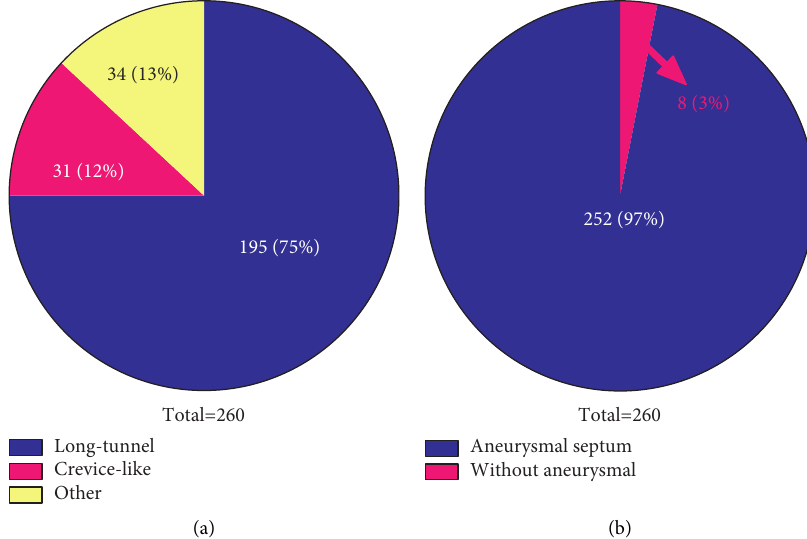
Figure 3: Anatomical classification based on transesophageal echocardiography. (a) Blue represents long-tunnel type, red represents crevice-like type, and yellow represents other type. (b) Red represents accompanied with aneurysmal septum and blue represents without aneurysmal